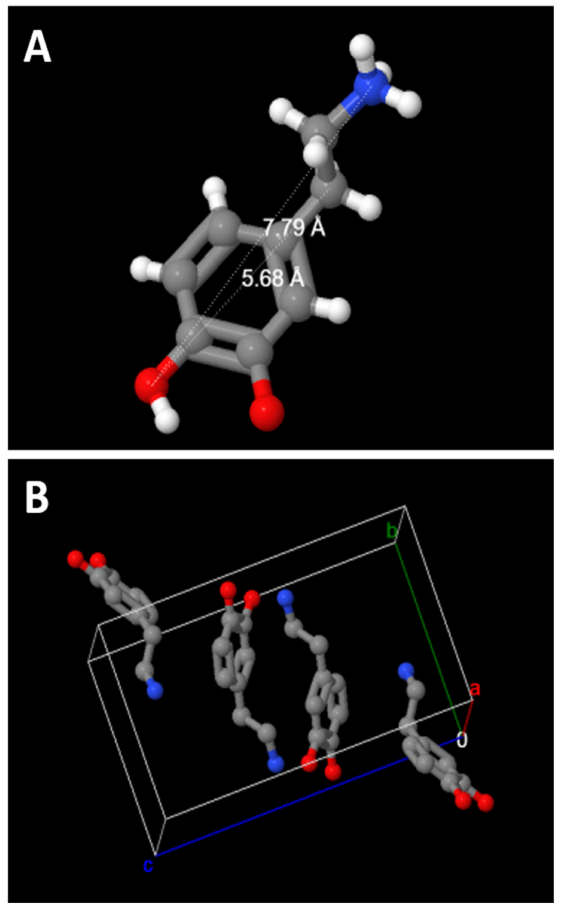
Figure A2. ( A ) Maximum length of single DA molecule and ( B ) unit cell length of four DA molecules.